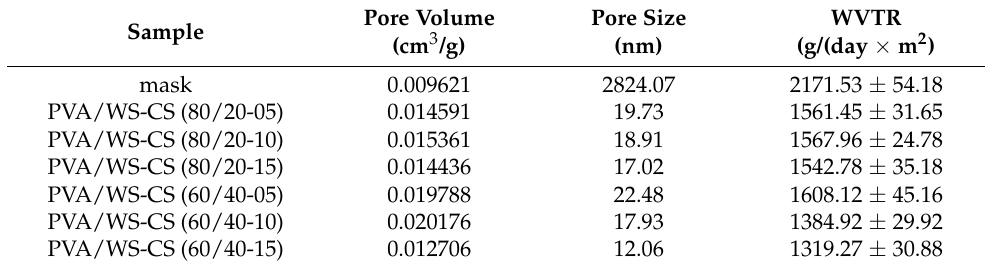
Table 2. Characterizations of PVA/WS-CS nanofibrous